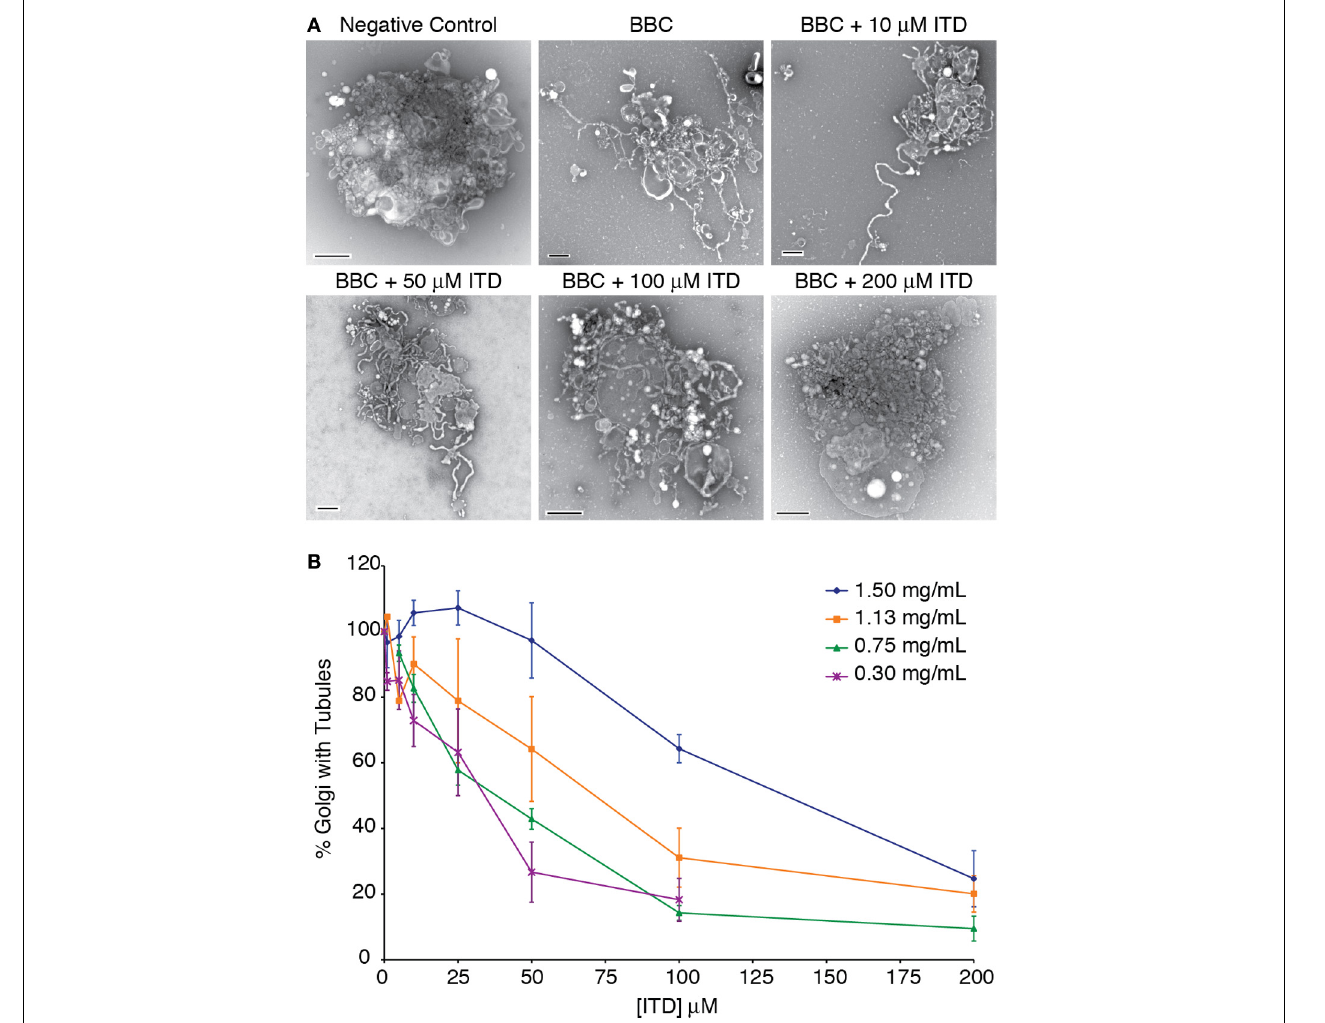
FIGURE 1 | Dose-dependent inhibition of cytosol-stimulated Golgi membrane tubules. (A) Example negative stain electron micrographs of tubulated and non-tubulated Golgi from the in vitro reconstitution assay. Bovine brain cytosol (BBC, 1.5mg/ml) was incubated with the indicated concentration of ITD and added to isolated Golgi complexes. Control Golgi